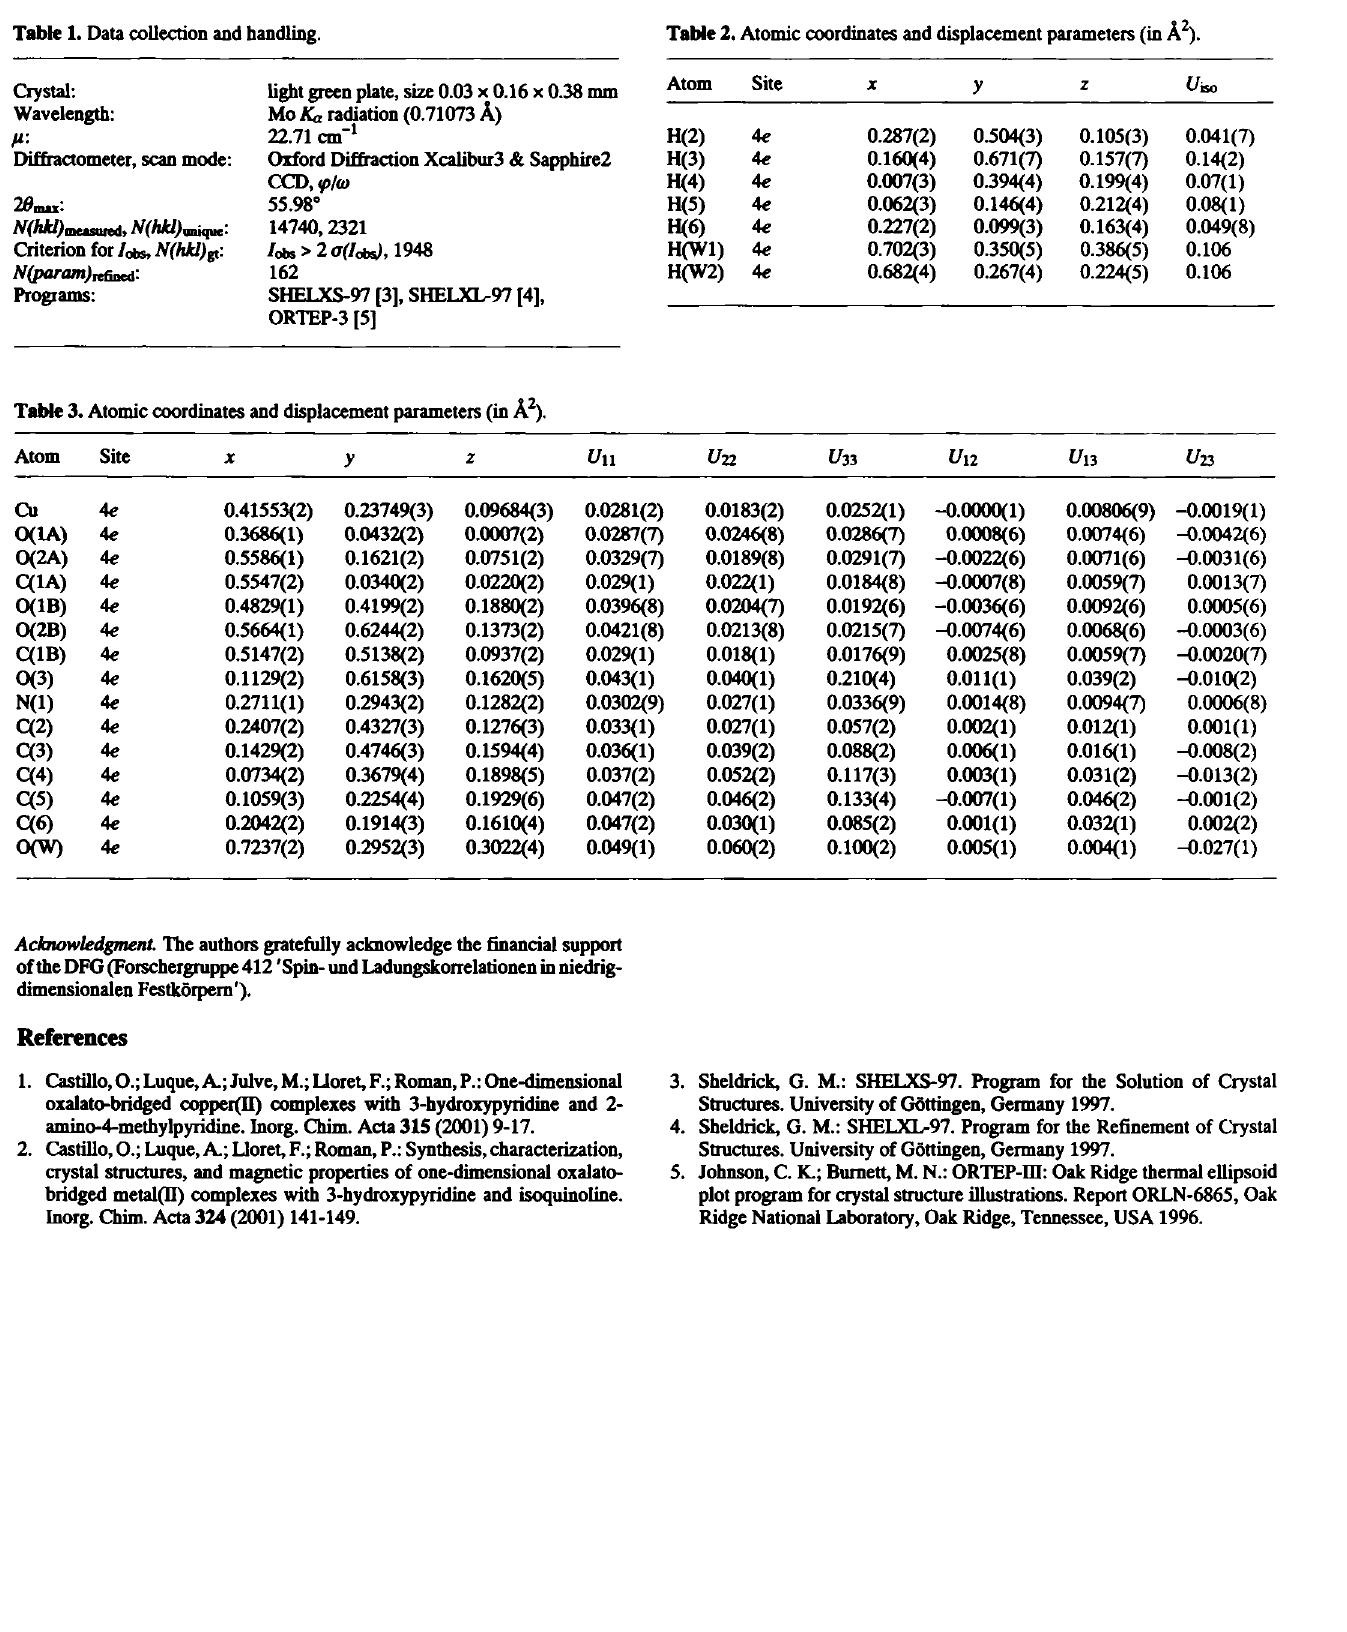
Table 3. Atomic coordinates and displacement parameters (in Ä 2